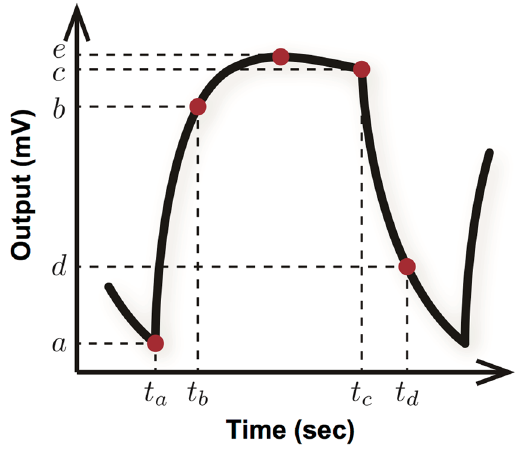
Figure 7. Schematic of a feature extraction of a signal measured by the MSS. Four parameters are defined as features by using a b c d e t t t , , , , , , , ,